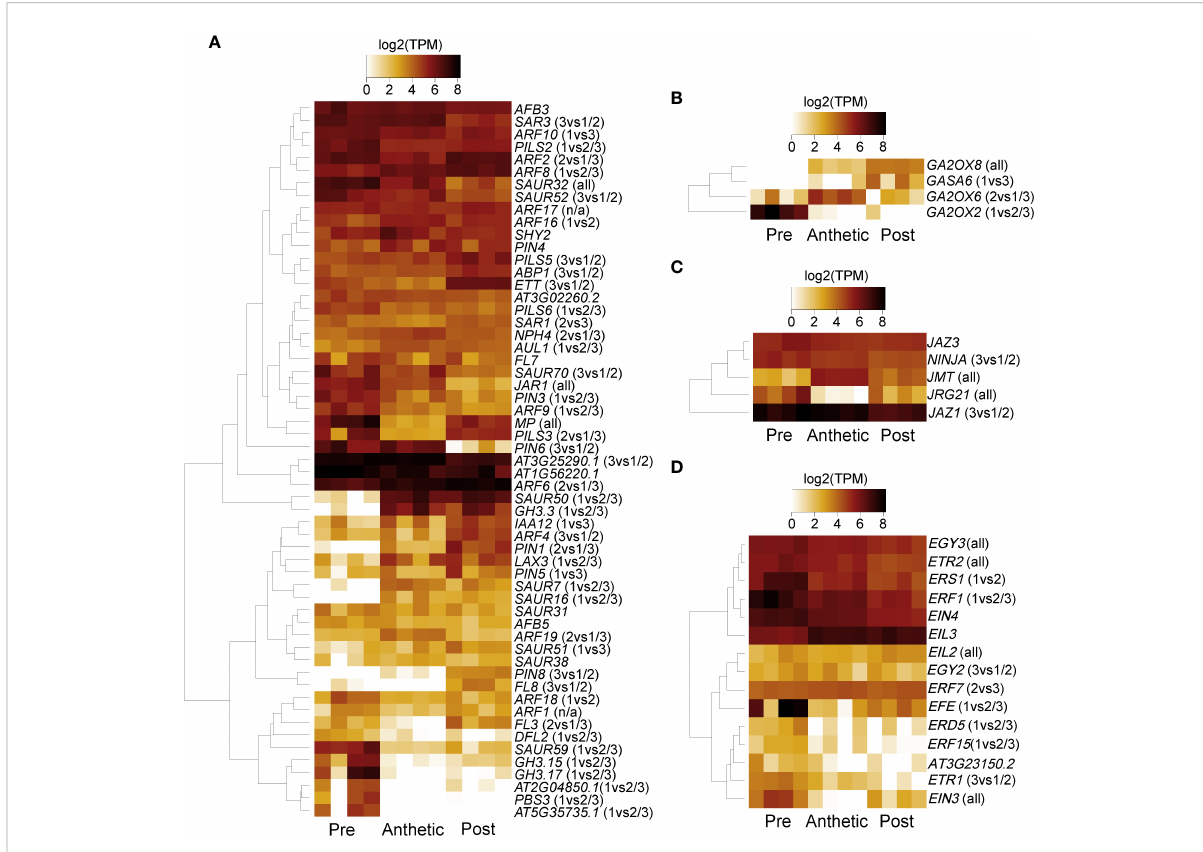
FIGURE 6 A heatmap of phytohormone-related transcripts expressed in pre-anthetic, anthetic, and post-anthetic nectaries of Cleome violacea displayed in log2(TPM). Representative transcripts of genes related to (A) auxin, (B) gibberellic acid (C) jasmonic acid, and (D) ethylene. Signi fi cance displayed in brackets. 1 = pre-anthetic; 2 = anthetic; 3 =